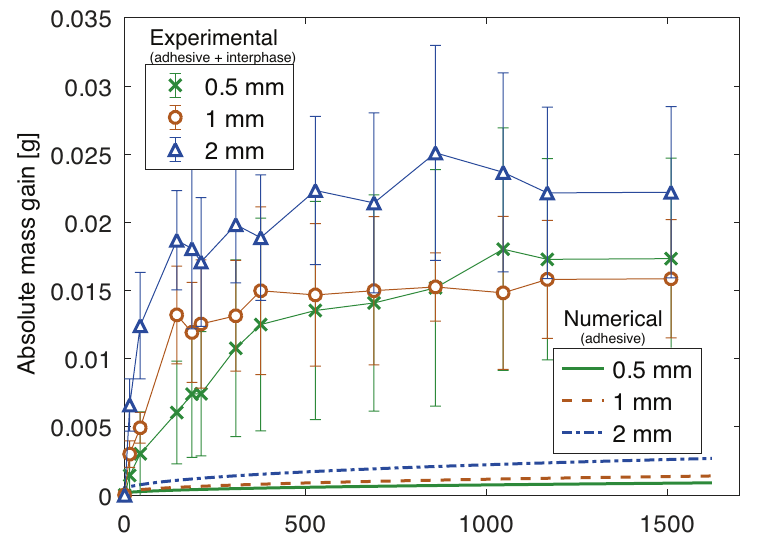
Figure 23. Mass gain due to water uptake of joints with aluminum substrates and 0.5 mm, 1 mm, and 2 mm thick adhesive: numerical (considering only water uptake in the adhesive) and experimental (considering adhesive and